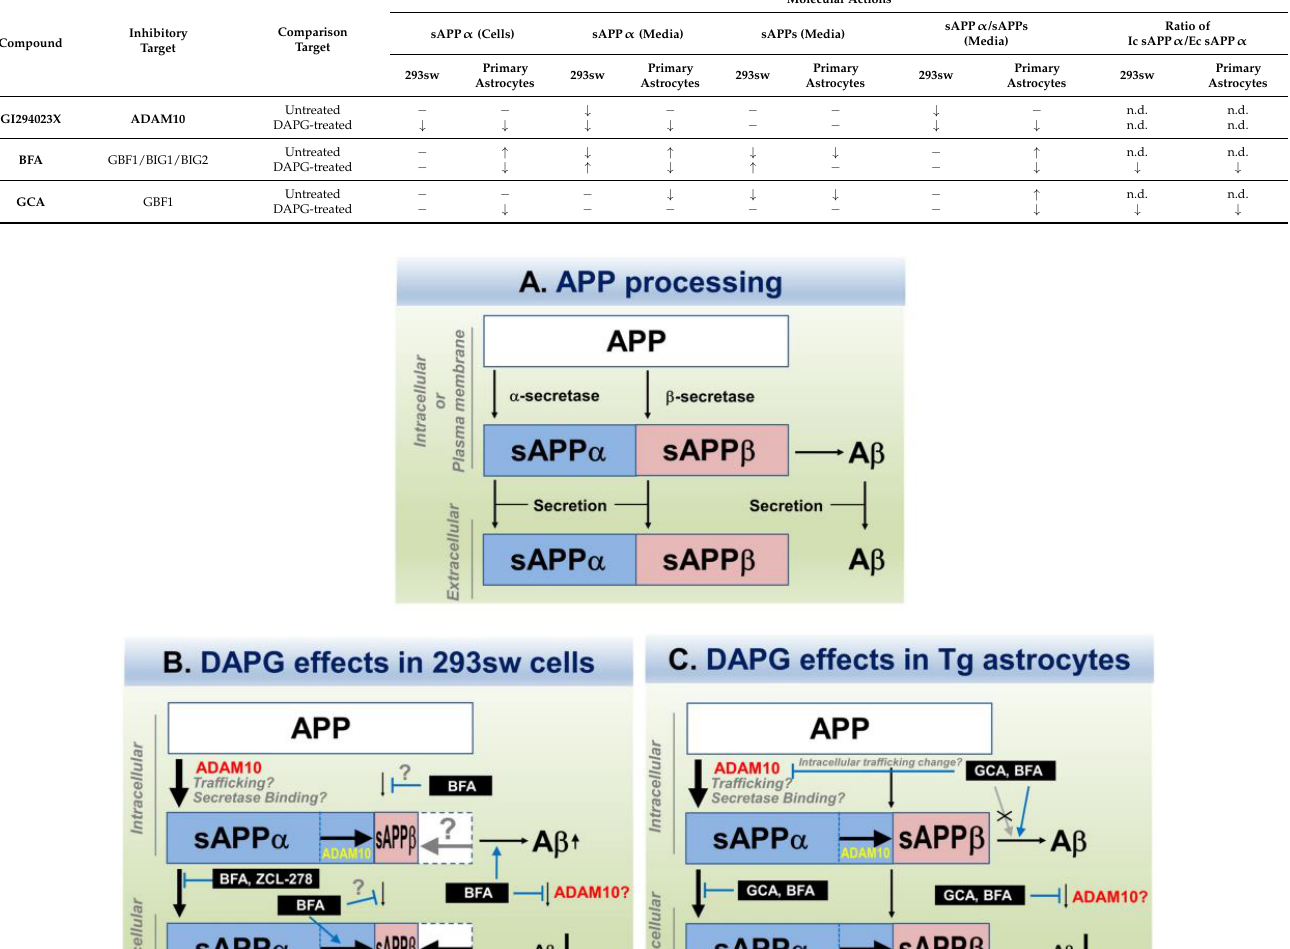
Table 3. Summary of changes in sAPPs parameters by GI293023X, BFA, or GCA alone and co- treatment with DAPG. Changes are shown compared to untreated cells (untreated) and DAPG- treated cells (DAPG-treated), respectively (Ic, intracellular; Ec, extracellular; n.d., not determined).